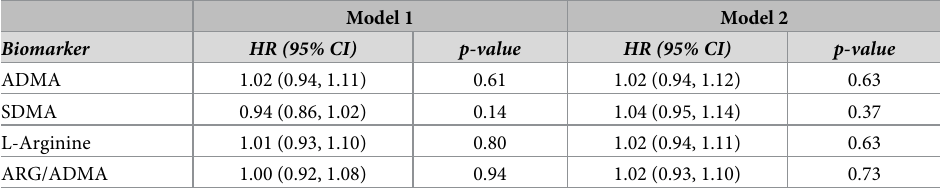
Data are displayed as hazard ratios (95% confidence intervals) per 1 standard deviation increase in the respective biomarker. Model 1 is adjusted for age, sex, smoking, and eGFR. Model 2 includes the adjustment variables in Model 1 plus waist circumference, SBP, DBP, glucose, HDL cholesterol, and